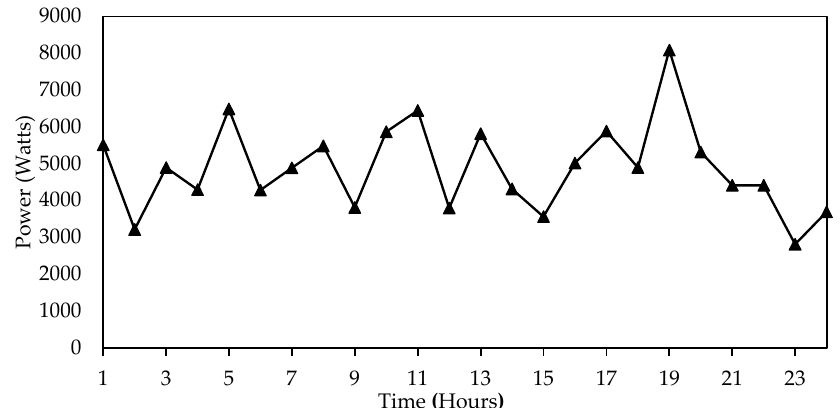
Figure 7. Demand curve of industrial load.